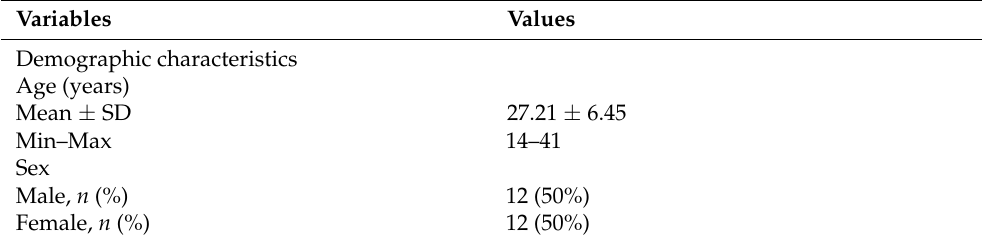
Table 2. Demographic data, treatment duration, oral hygiene practices, and dietary habits of the orthodontic